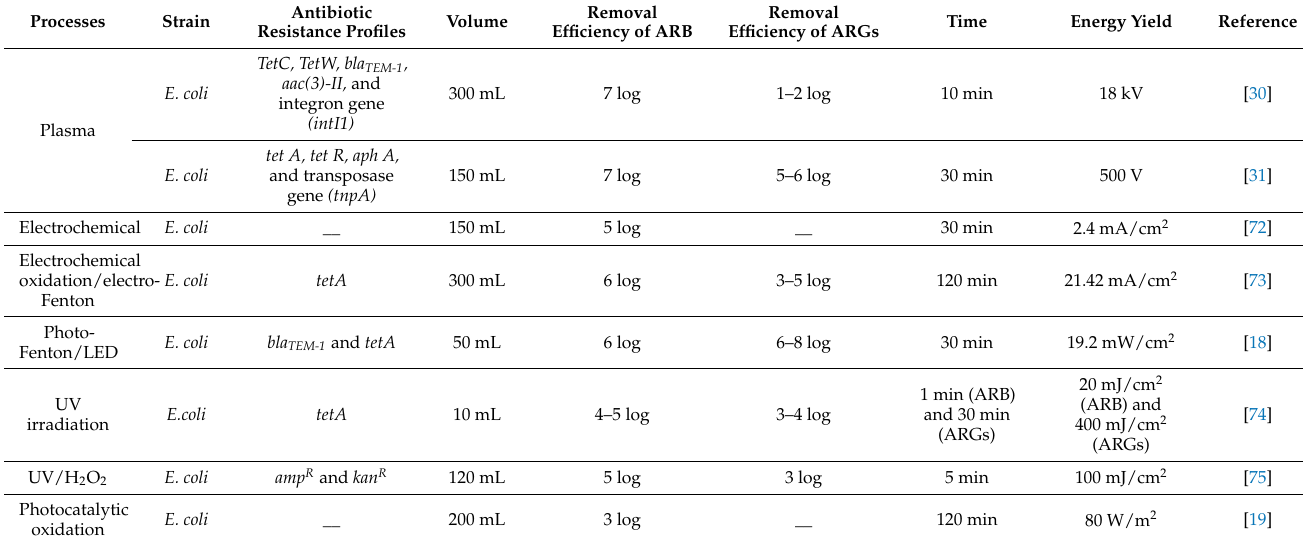
Table 3. ARG and ARB removal performance in the liquid phase by different